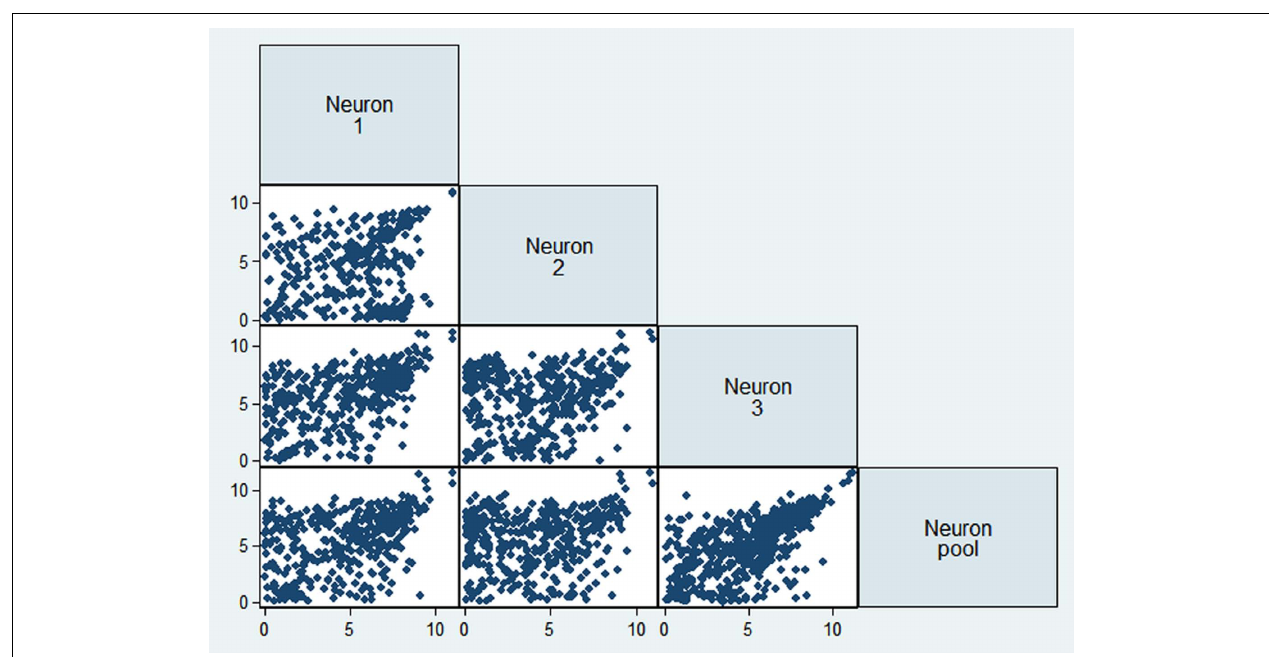
FIGURE 2 | Comparison of gene expression values (as logarithm of RPKM) from three single neurons and the 4-neuronal pool.